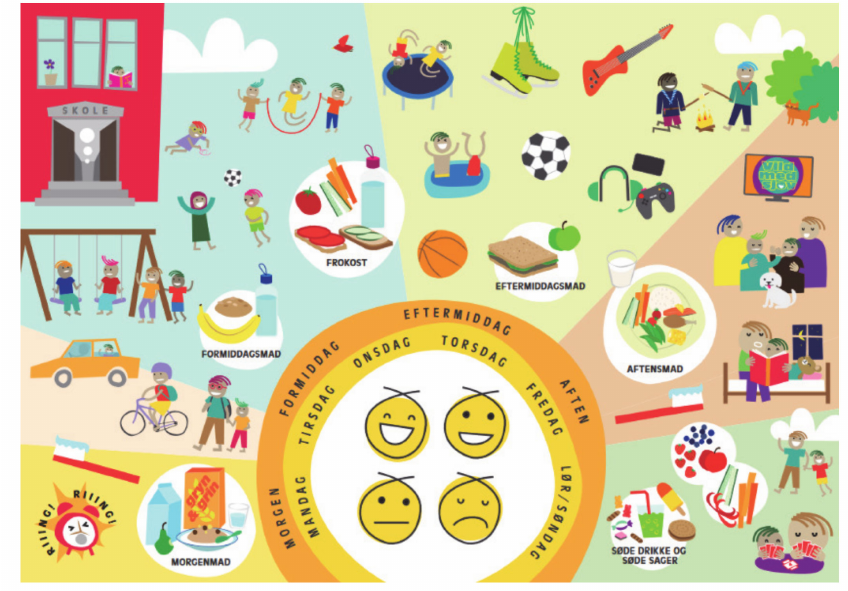
Figure 2. Conversation tool for school health